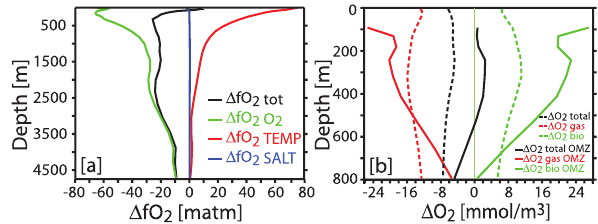
Fig. 8. Attribution to different drivers for changes (a) in f O 2 for the global ocean and (b) in dissolved O 2 for the entire Atlantic (dashed lines) and for Atlantic hypoxic waters ( O 2 < 50mmolm − 3 , solid lines). Results are from CSM1.4 and represent differences between 1870s and 2090s. Colors in panel (a) indicate total changes in f O 2 (black), f O 2 changes due to changes in dissolved O 2 (green), in temperature (red), and in salinity (blue). Colors in panel (b) indicate total O 2 changes ( ∆O 2 , black line), changes due to the air-sea O 2 disequilibrium ( ∆ O 2 gas , red), and to alterations in the cycling of organic matter ( ∆ O 2 bio , green).